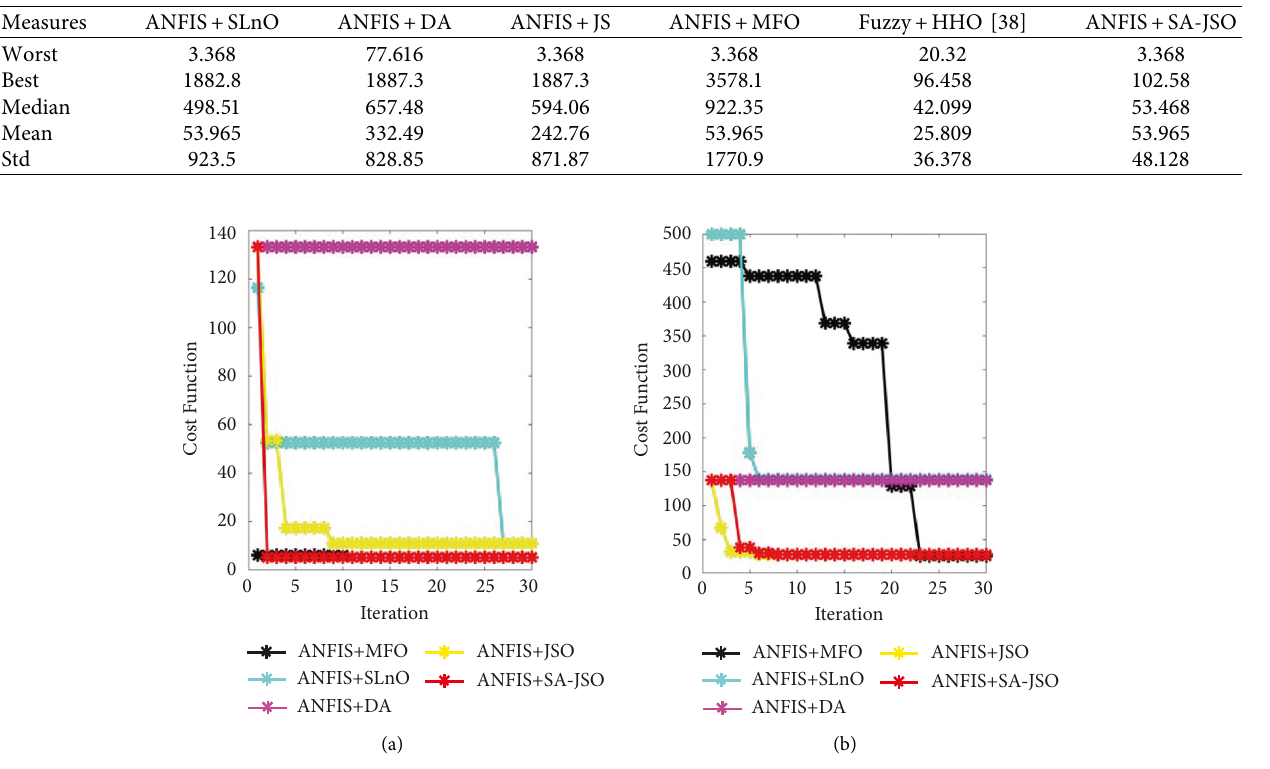
Table 6: Statistical analysis for adopted model over existing models for group 2 scenario.